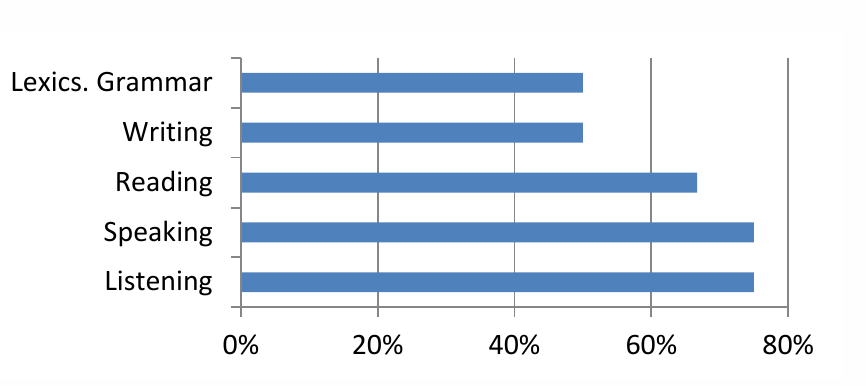
Figure 3. Answers to the question “What aspect of learning Russian do you like?”